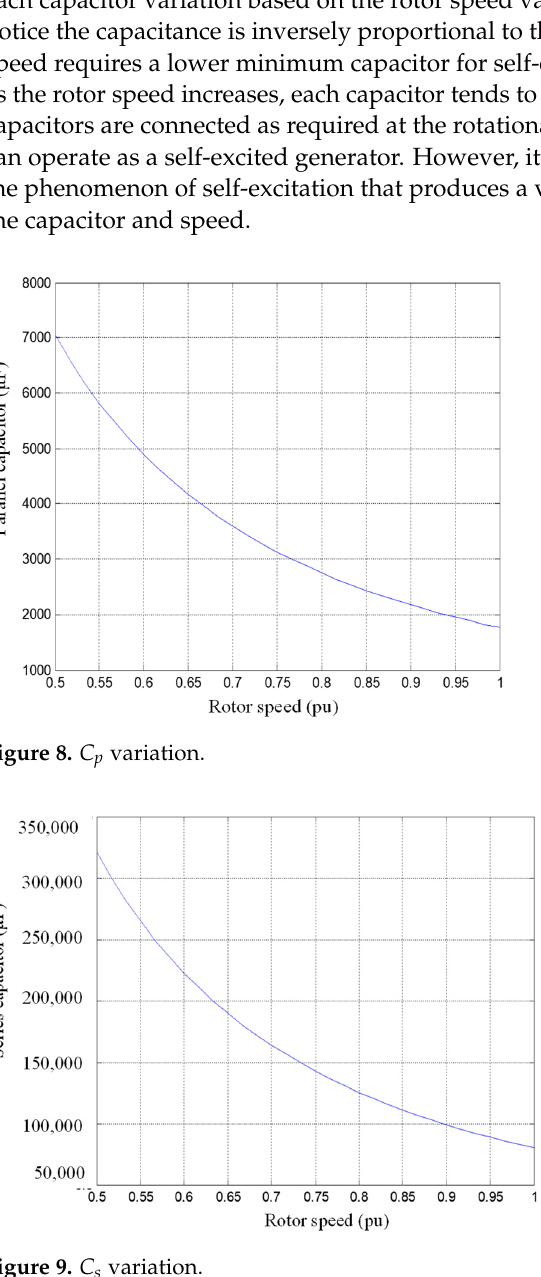
PWM signal Figure 7. Active power controller. 2.4. Capacitor Selections With the given machine parameters, the values of the capacitors for excitation can be determined. The values of the parallel capacitor C p and series capacitor C s for the excitation